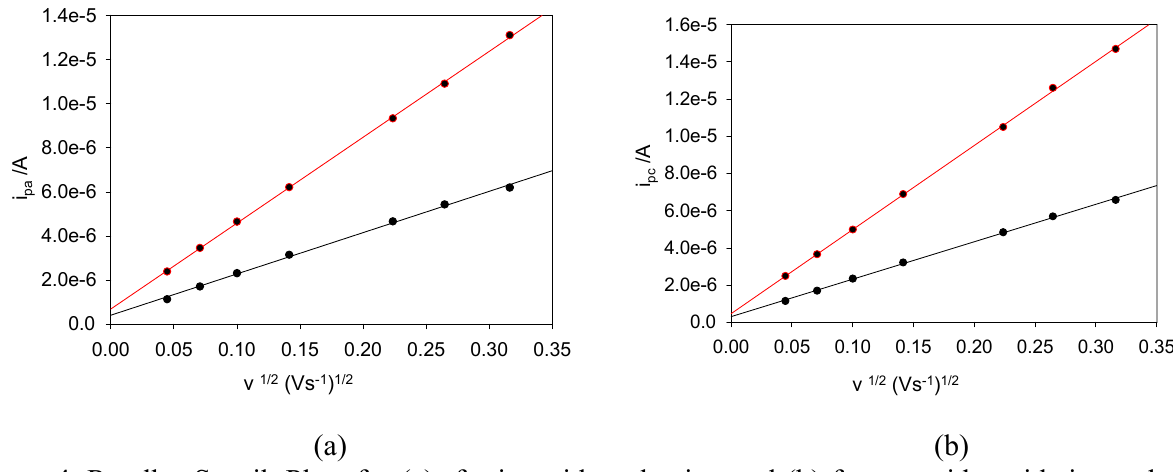
Figure 4. Randles-Sevcik Plots for (a) ferricyanide reduction and (b) ferrocyanide oxidation at bare and SWCNT modified gold electrodes. The upper curve denotes the SWCNT modified electrode data in each